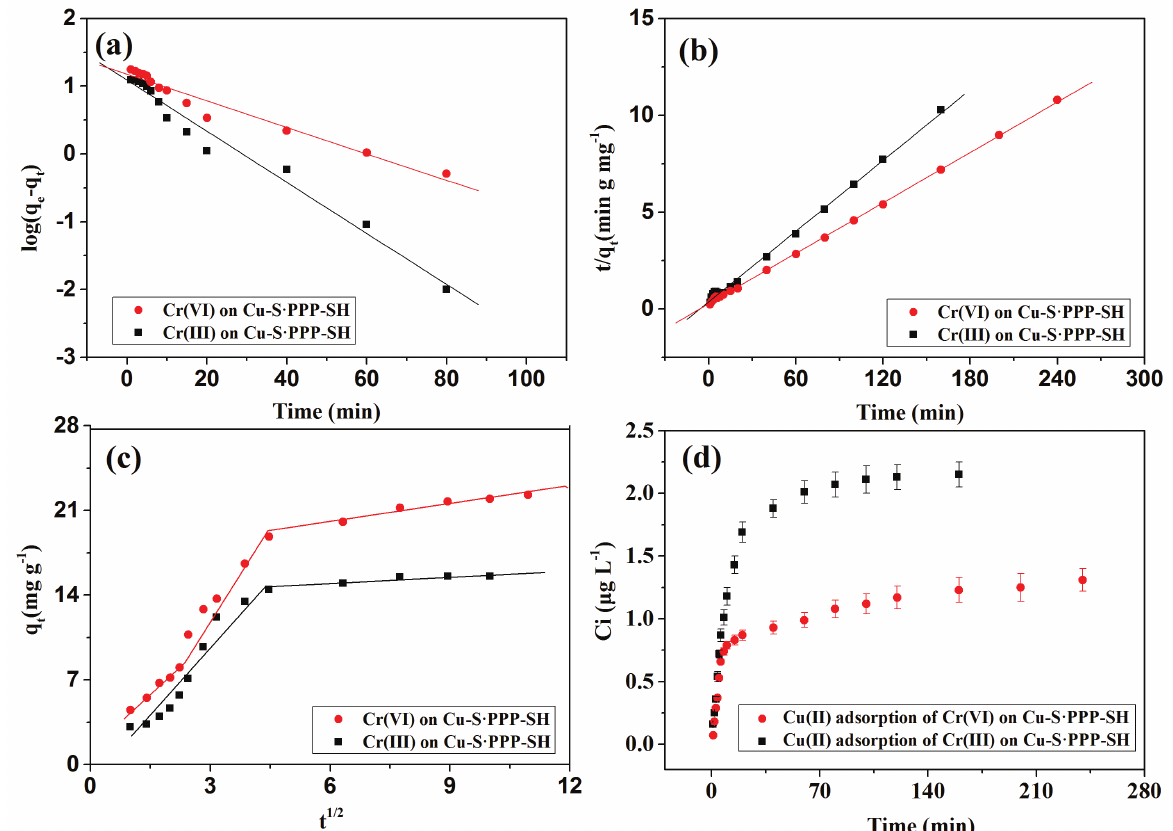
Figure 3: (a) Pseudo-first-order kinetics plot; (b) Pseudo-second-order kinetics plot;(c) Intra-particle diffusion kinetic plot; (d) Variation of concentrations of Cu(II) with time after adsorption in both systems.